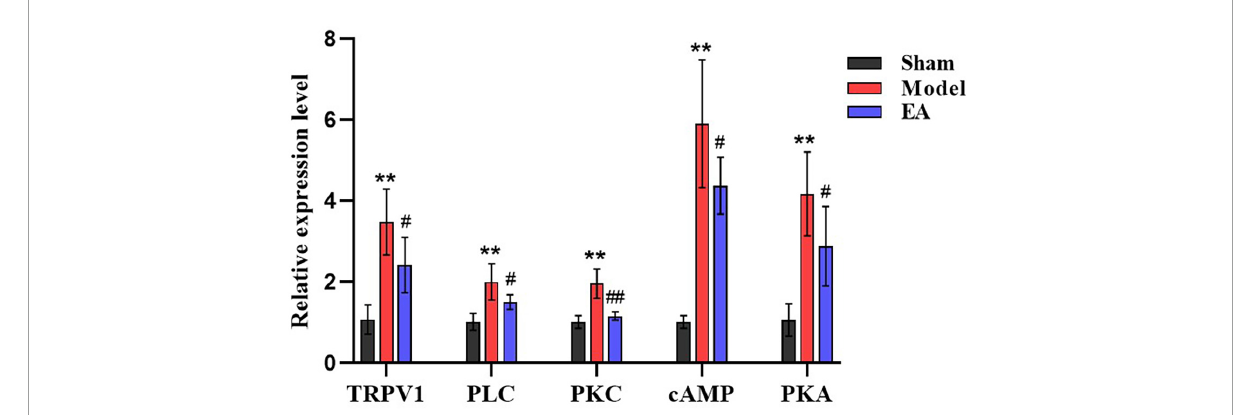
FIGURE9 Results of qRT-PCR in each group ( n = 6, ¯ x ± s). The X -axis is the gene name and the Y -axis is the relative expression of the gene. Compared with the sham group, ∗∗ P < 0.01. Compared with the model group, # P < 0.05 and ## P <